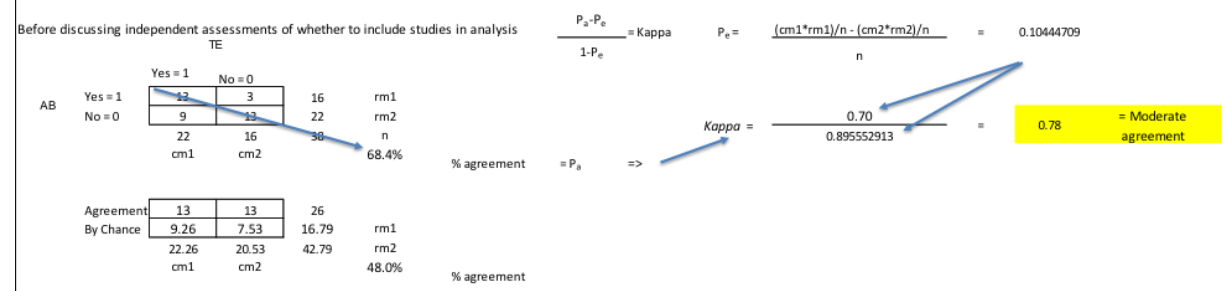
Figure 3. Calculation of kappa statistic using a series of Chi-square